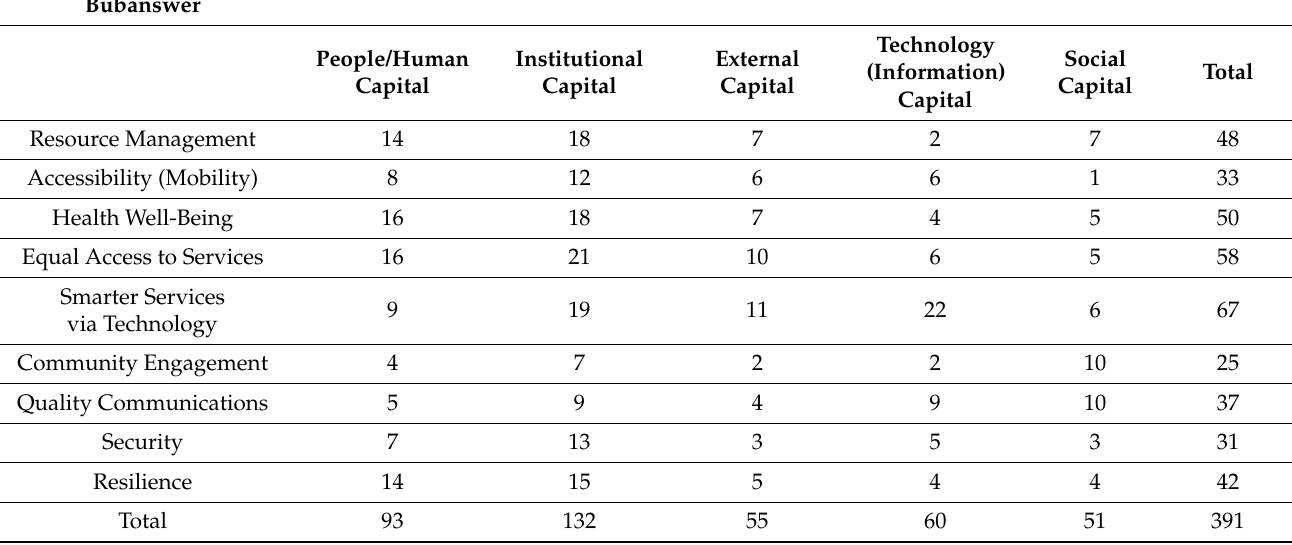
Table 2. Number of actions/initiatives (soft asset